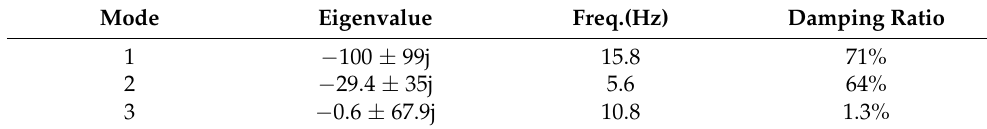
Table 1. Oscillatory modes of equilibrium point after active power climbing.